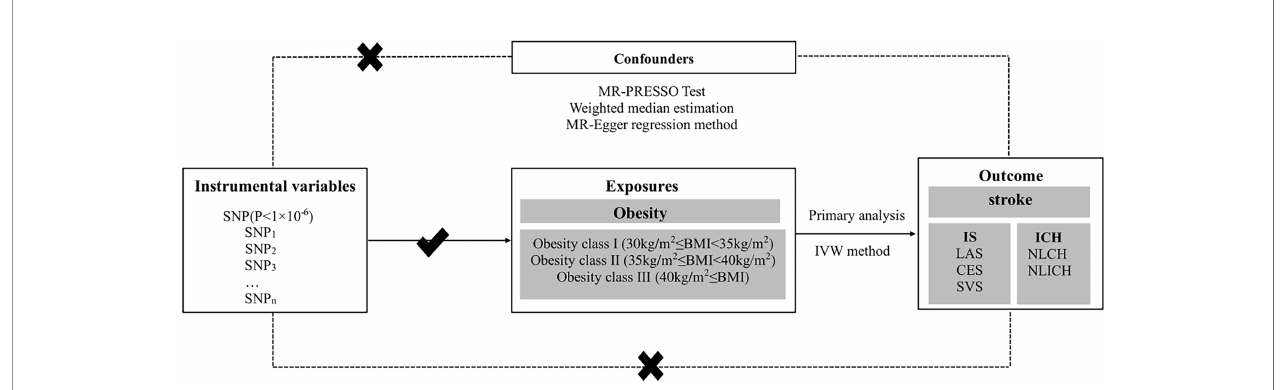
FIGURE 1 | Conceptual framework fi gure of exploring the causal relationship in different obesity classes and stroke with its subtypes in the MR analysis. MR, Mendelian randomization; IS, ischemic stroke; LAS, large artery stroke; CES, cardioembolic stroke; SVS, small vessel stroke; ICH, intracerebral hemorrhage; LICH, lobar intracerebral hemorrhage; NLICH, non-lobar intracerebral hemorrhage; IVW, inverse-variance weighted; WME, weighted median estimation; MR-PRESSO, MR pleiotropy residual sum and outlier.